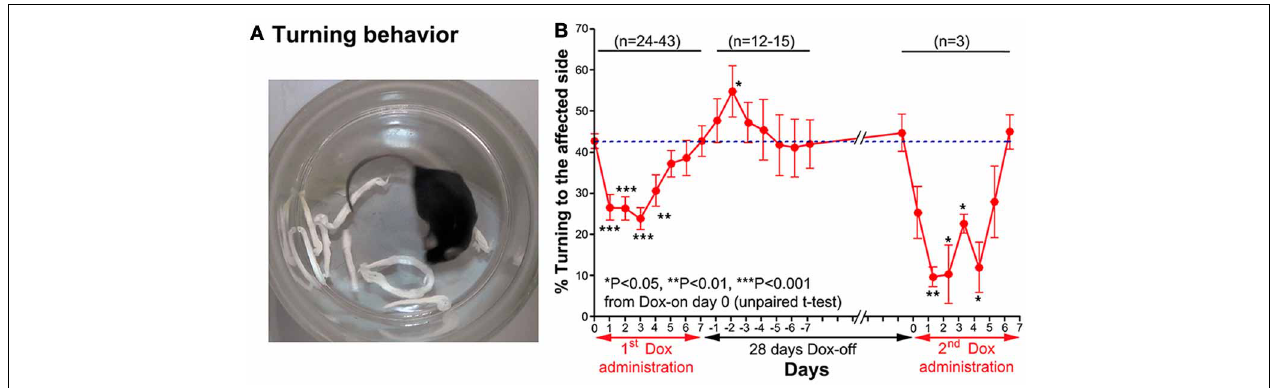
FIGURE 4 | (A) A photograph showing the turning behavior of a mouse to the unaffected side (right). (B) Effect of the Tet-induced tetanus neurotoxin-expressing system on turning behavior after the 1st Dox administration for 7 days, termination of Dox administration for 28 days, and the 2nd Dox administration for 7